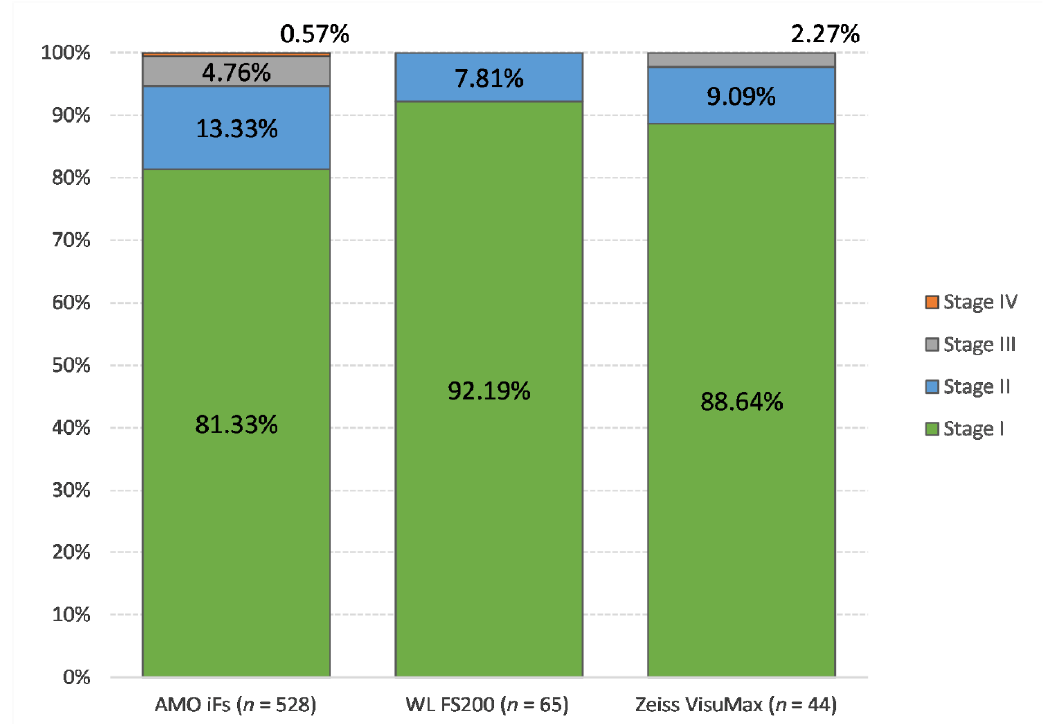
Figure 1. Comparison of DLK stages between laser types. Table 3. Demographics comparison between different grades of